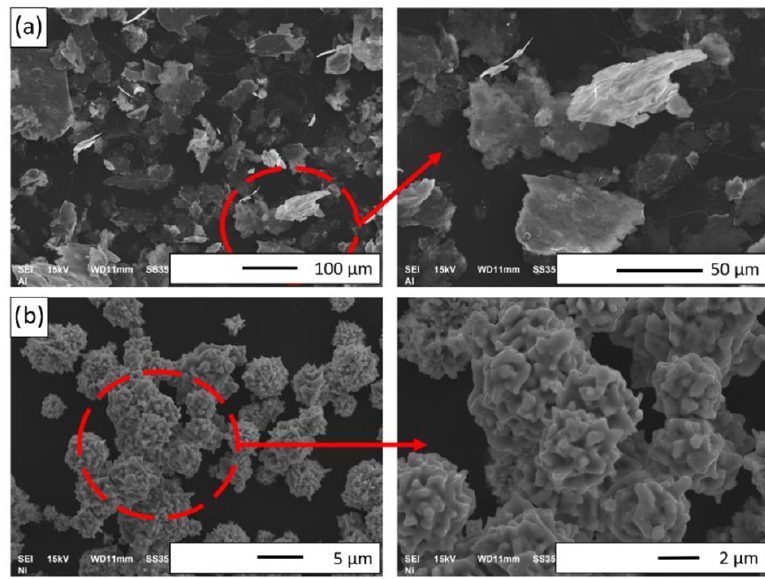
Figure 4. SEM images of initial powders: ( a ) Al and ( b ) Ni. The densities of the Al 2 O 3 , Ni, and Al powders were measured with a helium